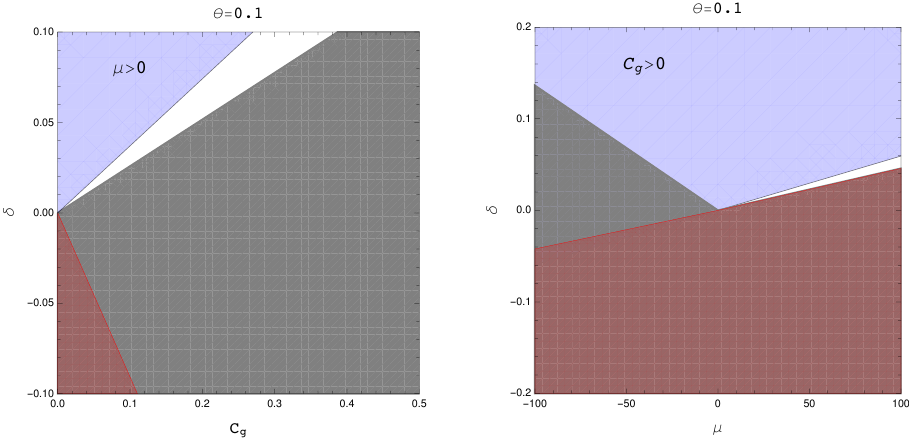
Figure 3 . Allowed region in the A L - D R model for (cid:18) = 0 : 1. The unaccessible grey area is determined by one neutral pseudo-scalar state becoming tachyonic. In a subset of this region, highlighted in red, one charged scalar also has negative mass squared. The plots are given in the C g - (cid:14) and (cid:22) - (cid:14) planes. For each value of (cid:14) , there is a maximum allowed value of C g > 0 (left-panel) and a range of (cid:22) (right-panel) in order to avoid